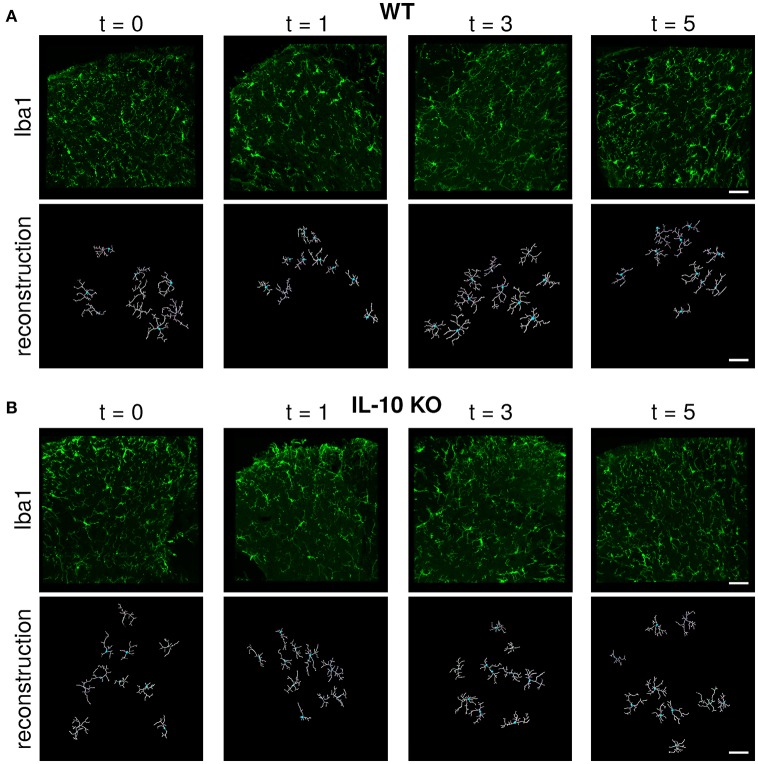
Immunofluorescent labeling and IMARIS reconstruction of microglial morphology in the spinal cord dorsal gray matter over time after LPS injection in WT and IL-10 KO mice. Representative examples of Iba-1 labeled microglial morphology (green) in naive mice or 24 h, 3, and 5 days after systemic LPS (0.33 mg/kg i.p) in (A) WT and (B) IL-10−/− mice. Below each Iba-1 image is the respective IMARIS reconstruction of microglial morphology (white). Dorsal horn gray matter was imaged, as shown. Scale bar = 50 μm.